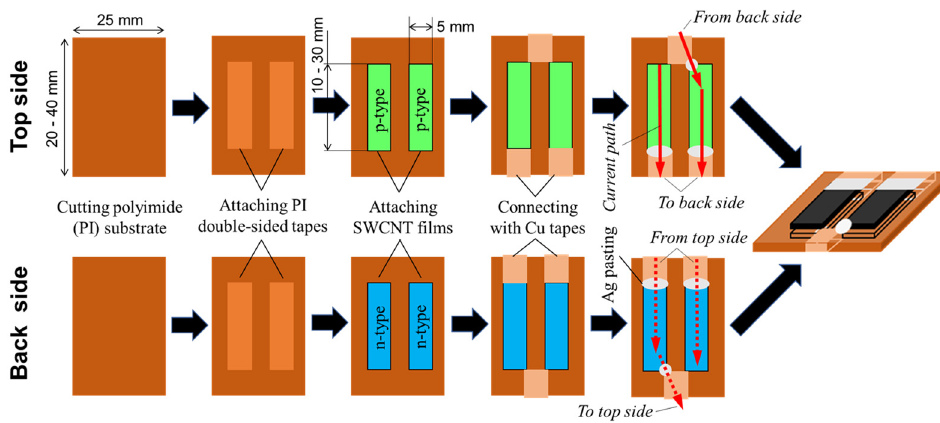
Figure 1. Schematic diagram of the manufacturing process of DFTEGs.